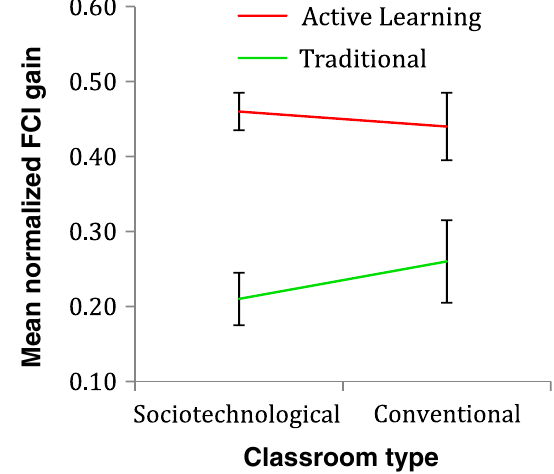
FIG. 1. The difference pedagogy makes on conceptual normal- ized gain is significant. Classroom settings alone do not con- tribute significantly to conceptual gain. Error bars represent the standard error to the mean.